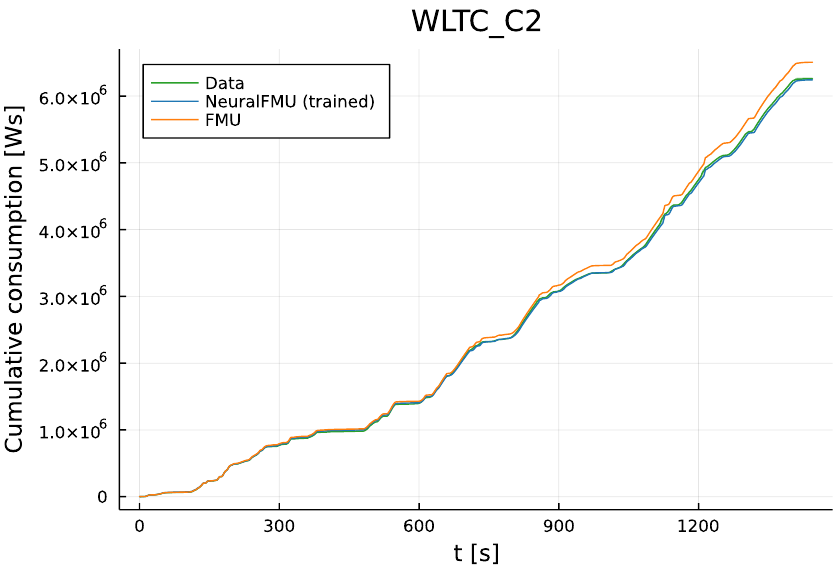
Figure 13. Comparison of the cumulative consumption prediction, using the WLTC Class 2 , which is not part of the NeuralFMU training data. As for the training data, the NeuralFMU prediction (blue) is closer to the measurement data mean (green) than the original FPM prediction (orange).